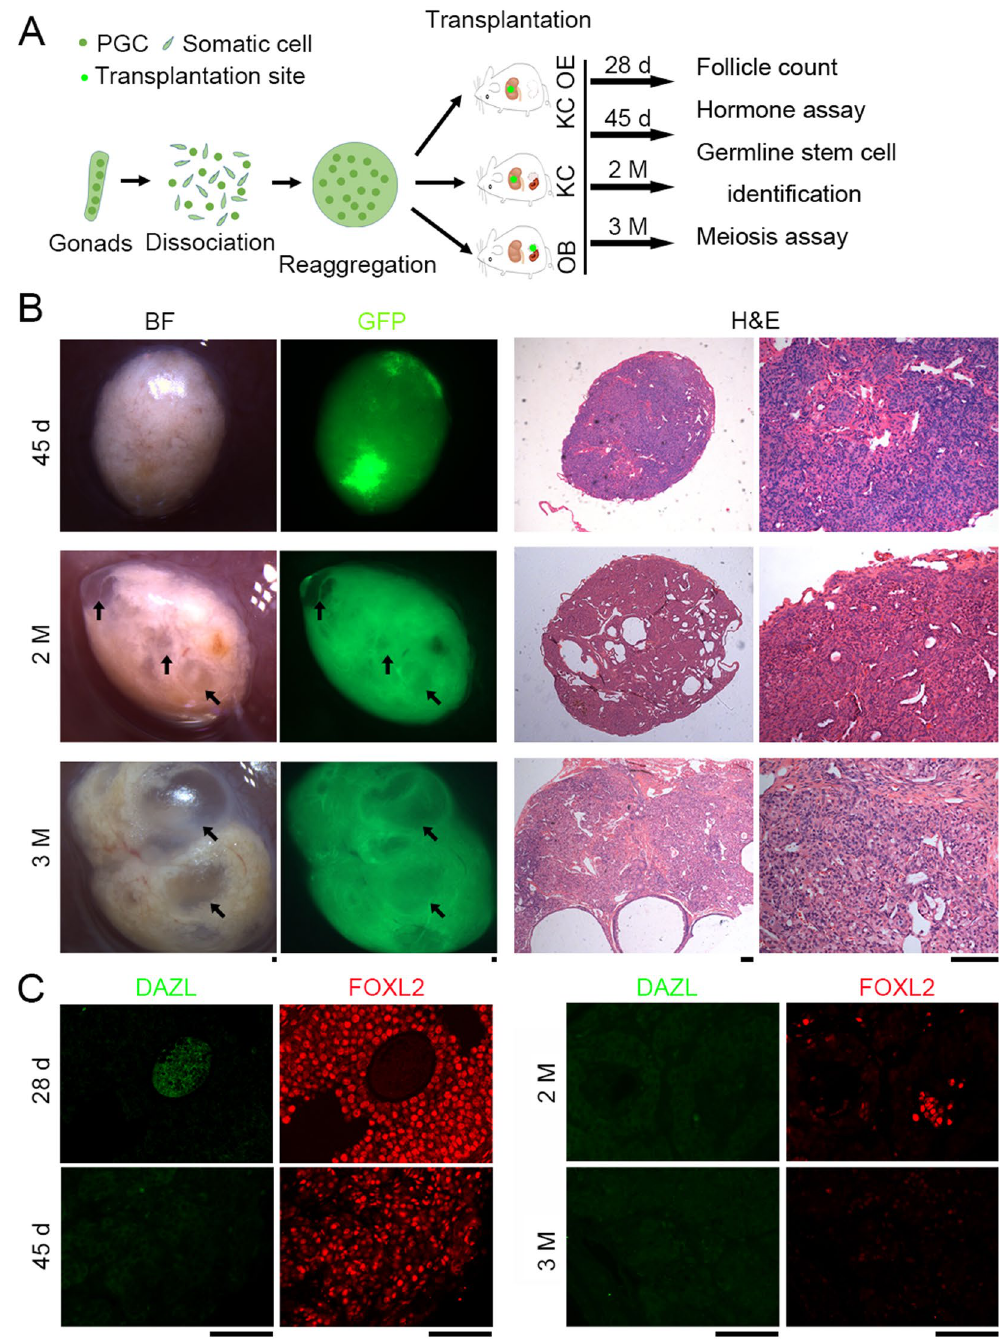
Figure 3. Loss of folliculogenesis 45 days following transplantation of PGCs- aggregates. ( A ) Experimental design for longer-term transplantation. Female gonads at 12.5-dpc were dissociated, and PGCs were aggregated with somatic cells from the same gonad and transplanted using various methods shown above. The grafts were retrieved 28 days, 45 days, 2 months and 3 months respectively after transplantation and subjected to the functional analysis as indicated. ( B ) Morphology of ovary like grafts collected at 45 days, 2 months and 3 months after transplantation by KC OE (left). Grafts collected at 28 days are similar to those shown in Fig. 1B KC OE. Follicles were undetectable in the sections by H&E staining following transplantation for longer-term (45 days, 2 months and 3 months) (right). Arrows indicate large vacuoles without follicles verified by H&E histology. ( C ) Co-immunostaining and fluorescence of residual cytoplasmic DAZL in oocytes and FOXL2 a specific marker for granulosa cells in grafts. Scale bar = 100 μ